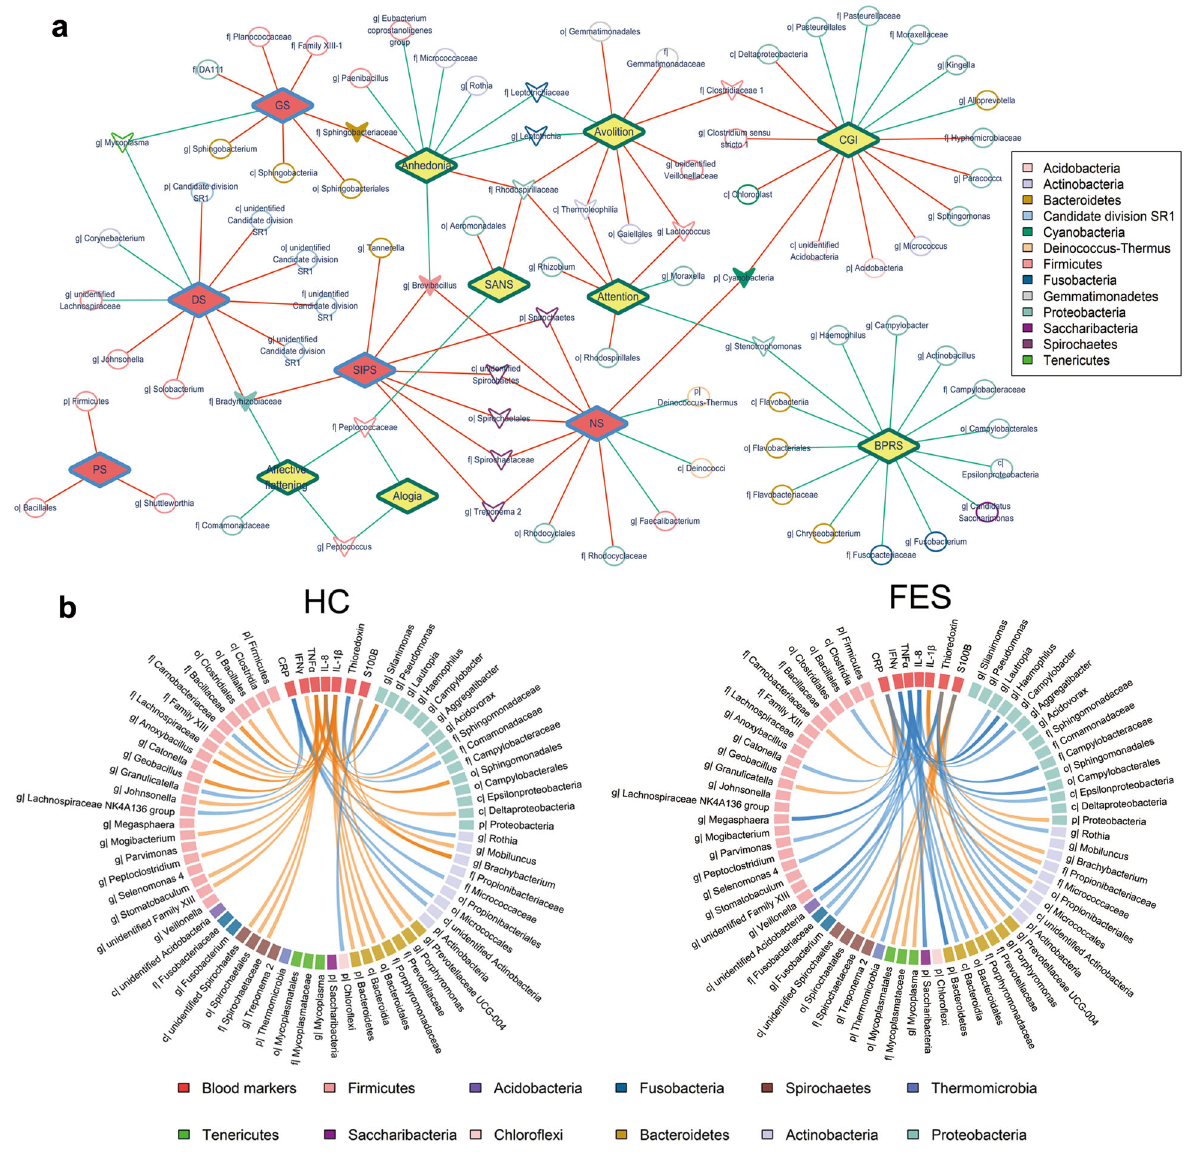
denote negative correlations. Yellow diamonds represent symptoms of schizophrenia, while red diamonds represent CHR symptoms. Ellipses denote taxa relevant to a single symptom of either schizophrenia or CHR, and hollow inverted triangles indicate taxa associated with more than one symptom of either schizophrenia or CHR, while solid inverted triangles represent taxa related to symptoms of both schizophrenia and CHR. b The Circos plot showed distinct relationships of salivary taxa with blood markers (CRP, IFN γ , TNF α , IL-8, IL-1 β , thioredoxin, and S100B) in the FES group relative to HCs. Orange curves denote positive correlations, while blue curves denote negative correlations. GS general symptom, DS disorganized symptom, NS negative symptoms, PS positive symptoms, SIPS structured interview of prodrome syndromes, BPRS brief psychiatric rating scale, CGI-S clinical global impressions severity scale, SANS scale for the assessment of negative symptoms, p phylum, c class, o order, f family, g